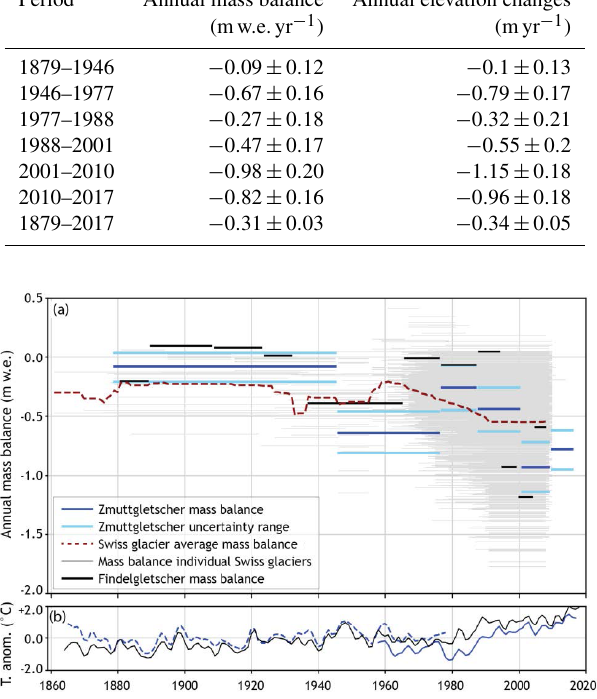
Figure 3. (a) Geodetic mass balance of Zmuttgletscher and Find- elgletscher (data from Rastner et al., 2016) in comparison to all Swiss glaciers. Mass balance data from WGMS (2017). (b) Evo- lution of air temperature anomaly (T. anom.) at the climate stations Col du Grand St. Bernard (black lines, 2472m, ∼ 40km) and Sion (blue lines, 484m, ∼ 35km). Note that the Sion climate station was slightly repositioned in the 1960s (dashed vs. solid blue). The air temperature data were smoothed with a 5-year running